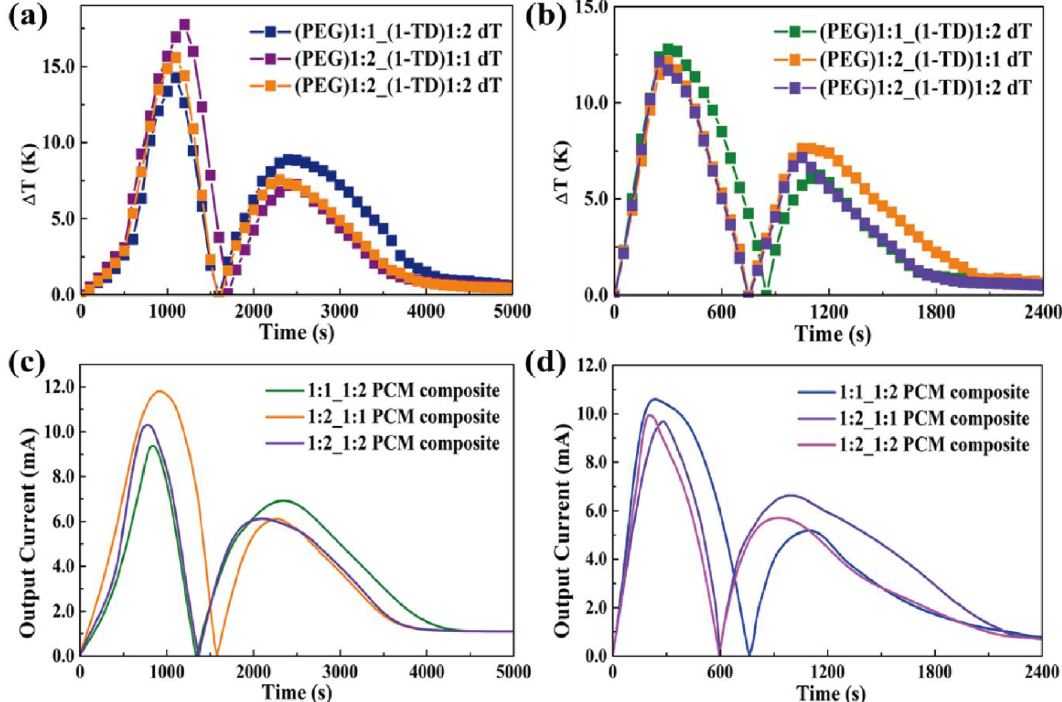
Figure 11. Optimization of components and temperature difference during the ( a ) heating process and ( b ) cooling process. Current curves of PCM composites during the ( c ) heating process and ( d ) cooling process.